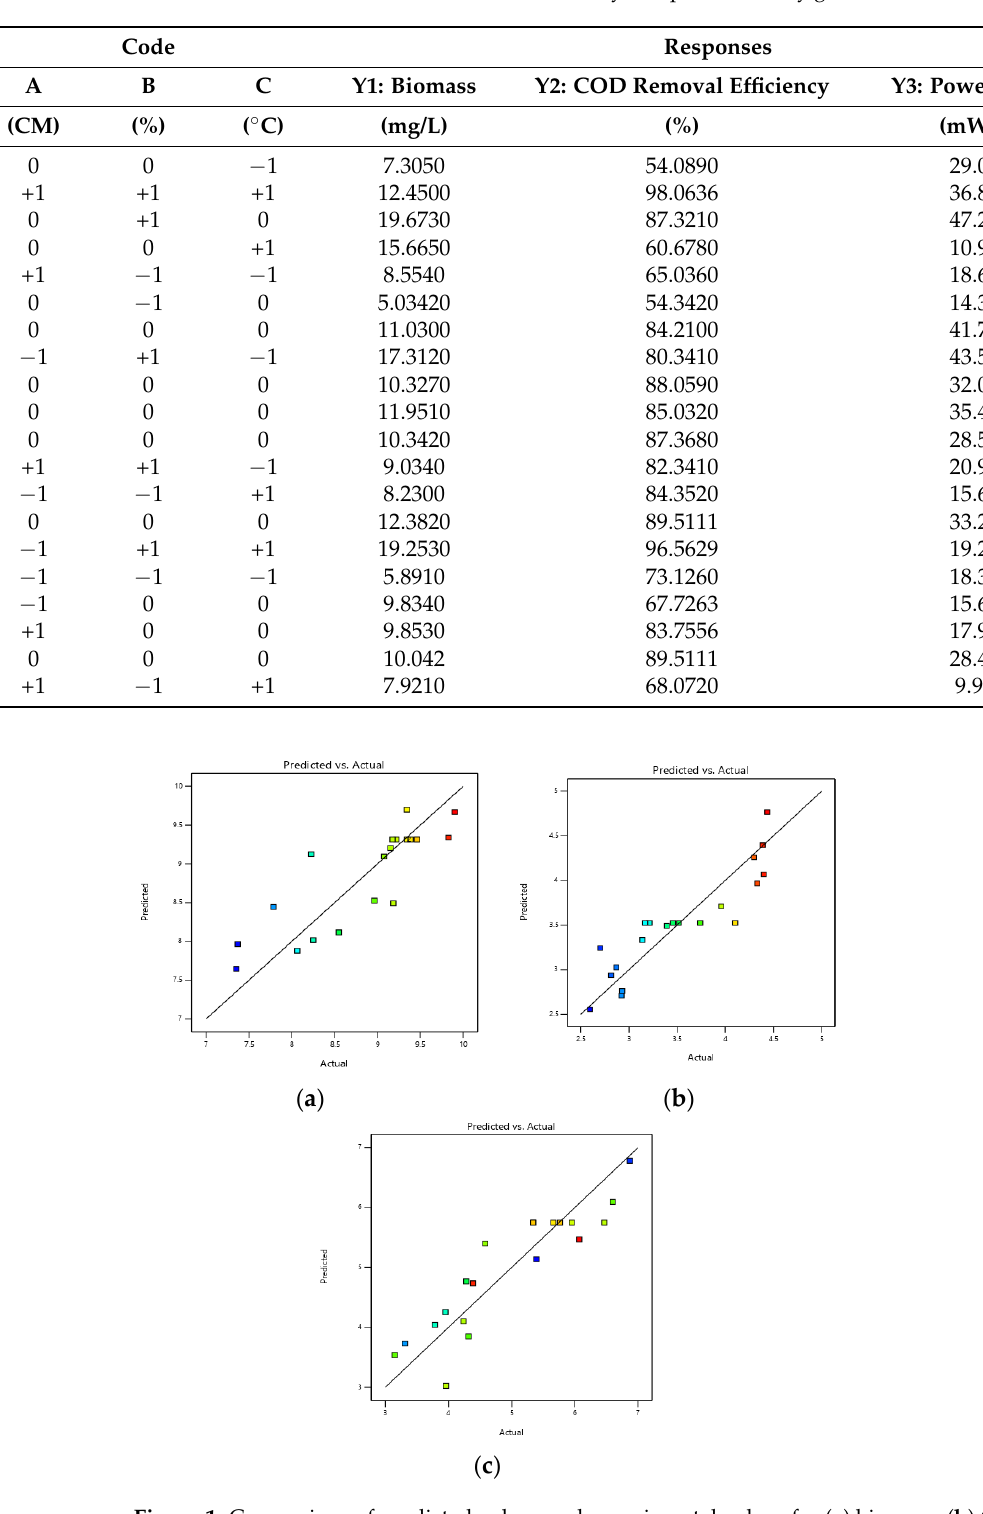
Table 2. Result of biomass COD removal efficiency and power density generation obtained with CCD.